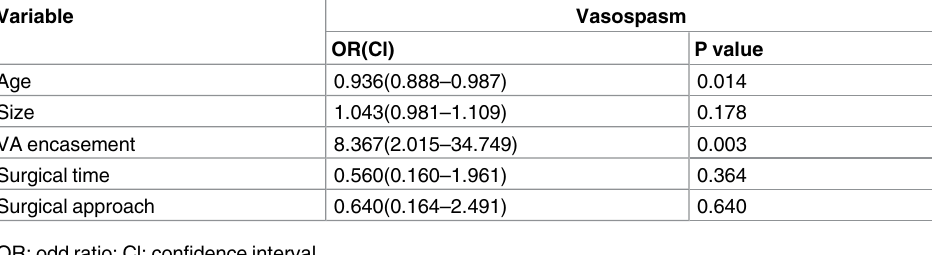
Table 2. Multivariate analysis of factors affecting postoperative